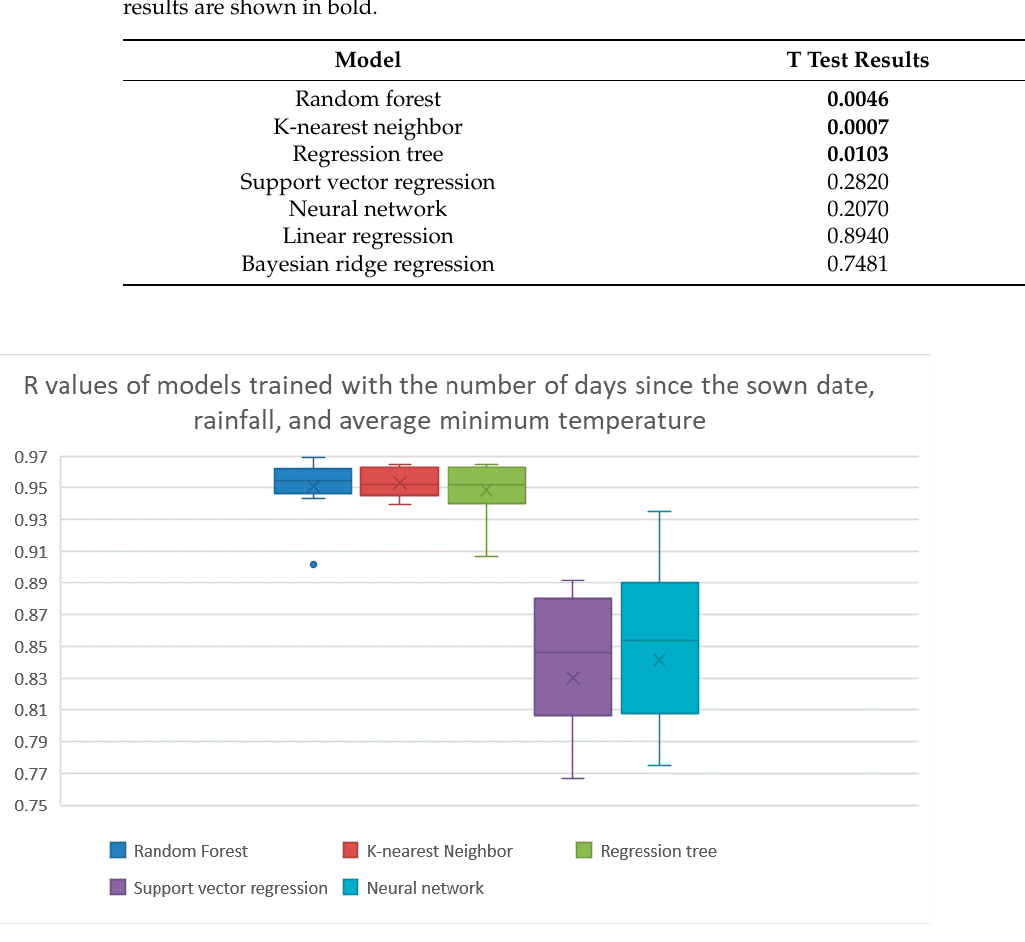
ridge regression were much lower than the other models, so their results are not shown here. The lower than the other models, so their results are not shown here. The results are shown explicitly in Table 7. results are shown explicitly in Table 7.